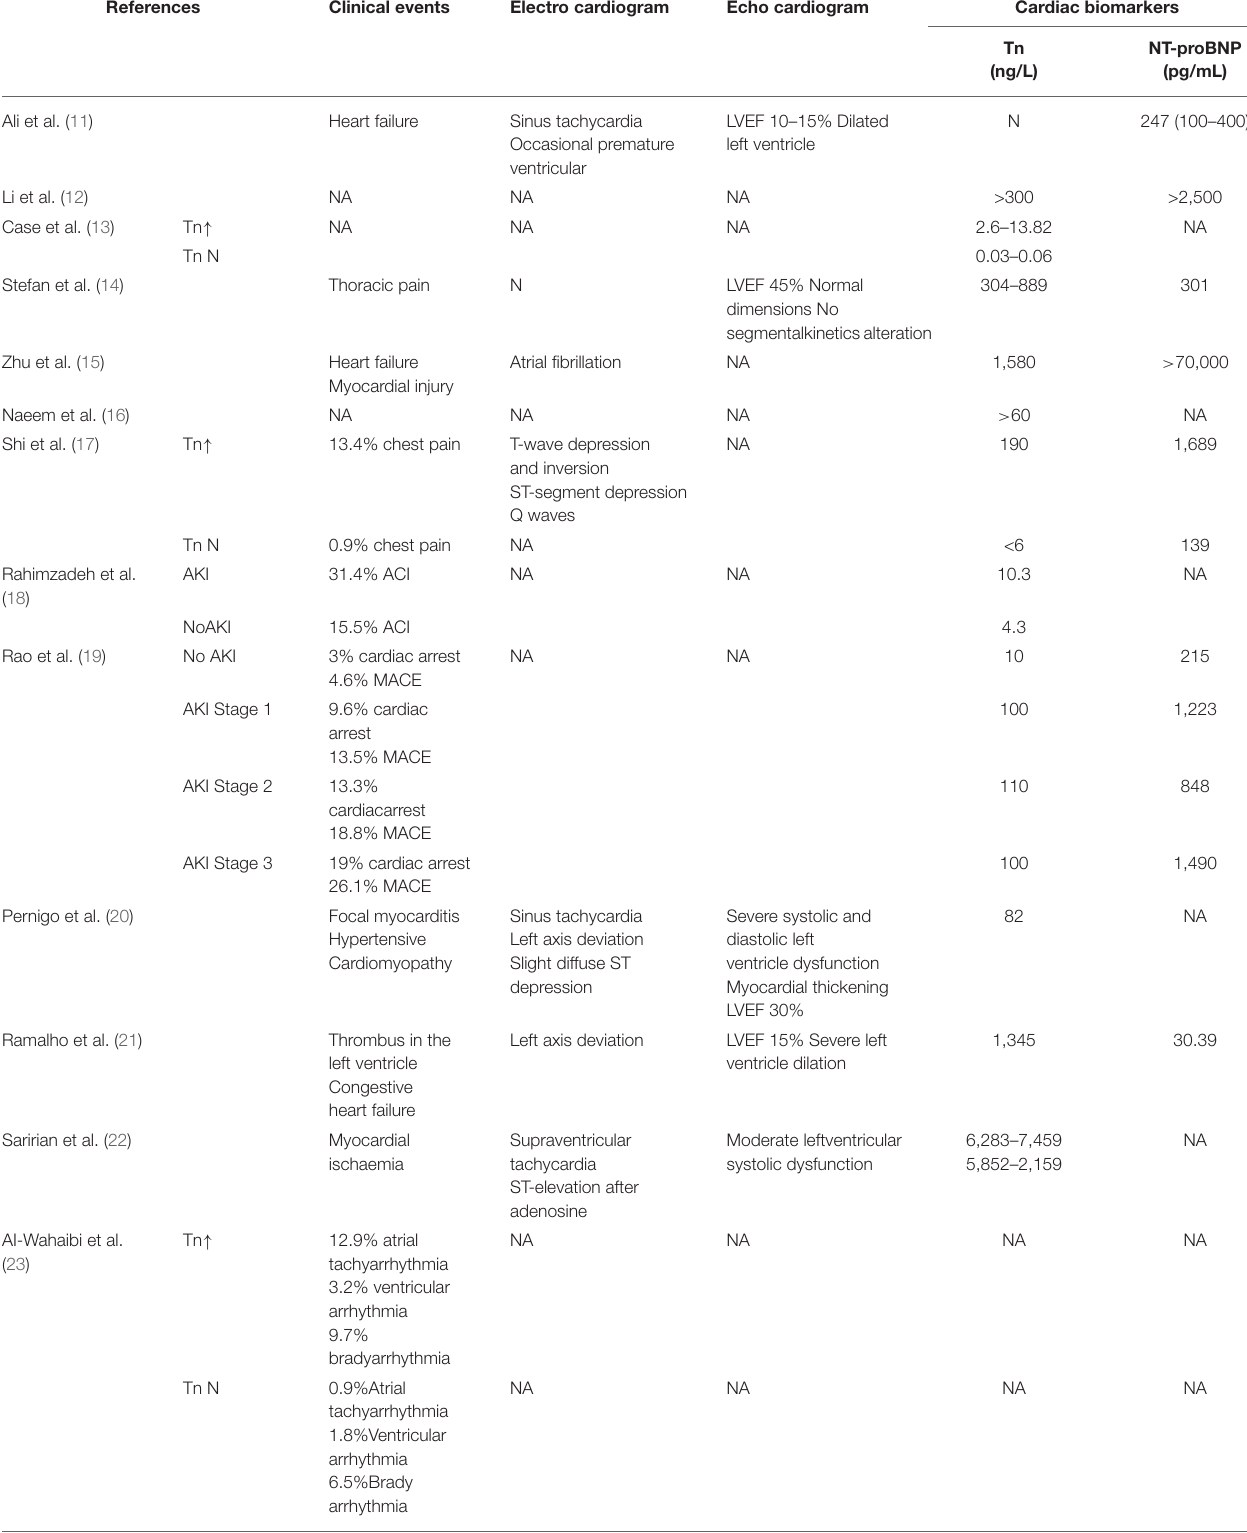
TABLE 2 | Clinical and laboratory findings of the heart in COVID-19 patients with cardiac and renal